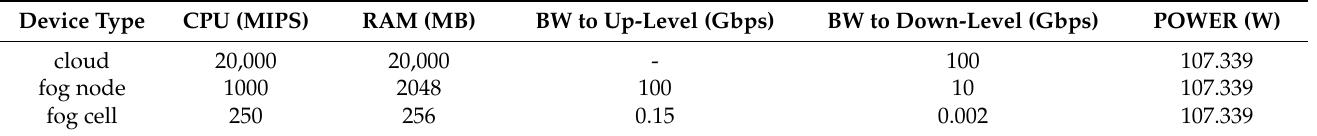
Table 4. Configuration of different computational devices.